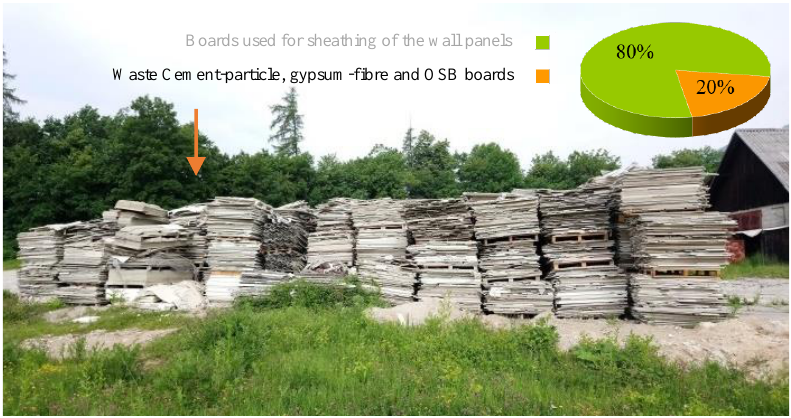
Figure 1. Residual waste boards arising from light-frame timber panels production in the manufac- turing of prefabricated timber buildings.